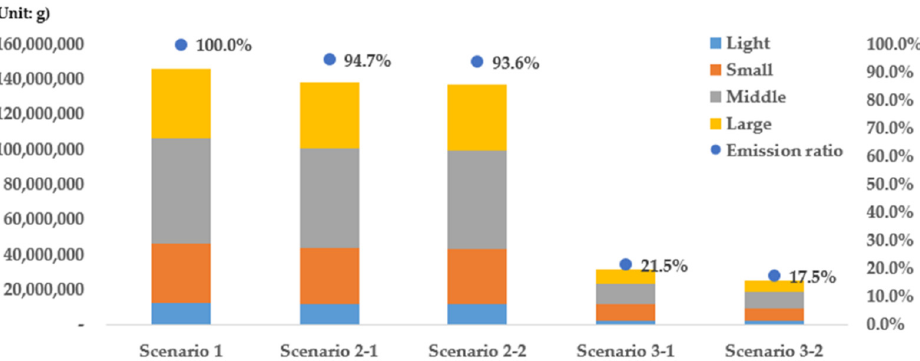
Figure 18. Vehicular emissions and emissions ratios by vehicle size. Table 5. Vehicular emissions and reduction efficiency by vehicle size.